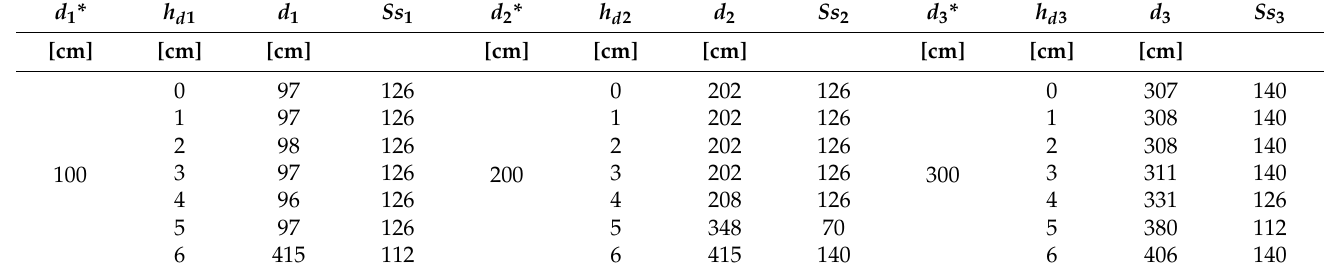
Figure 9. Powerful light on target object.